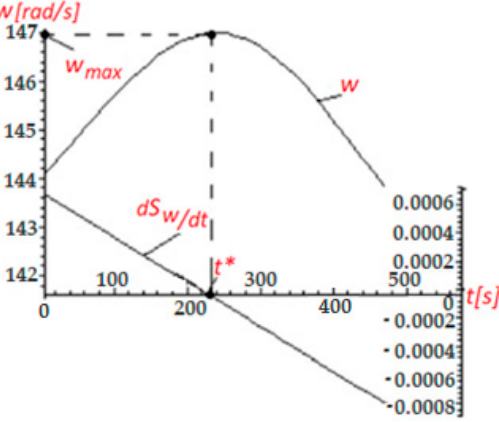
( t ) (𝑡) . Figure 6. Time variation of the PMSG’s angular speed ω ( t ) and of the wind speed derivative dS w dt (cid:3031)(cid:3047)